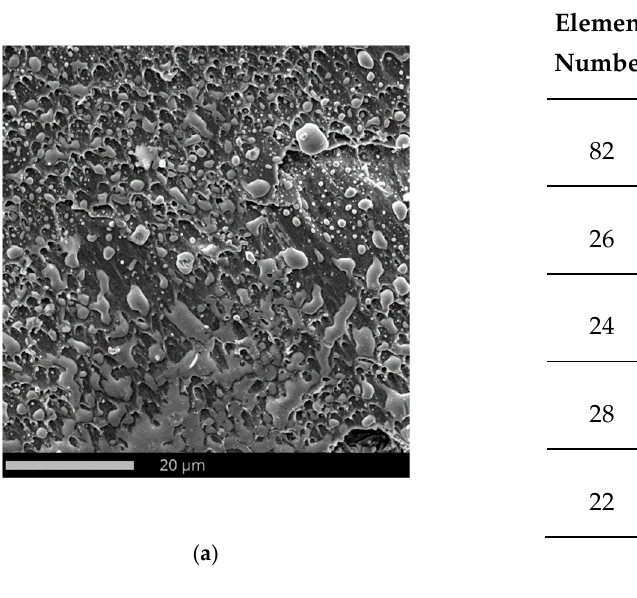
projectile entry ( a ) and listing the most important chemical elements on the analyzed surface ( b )